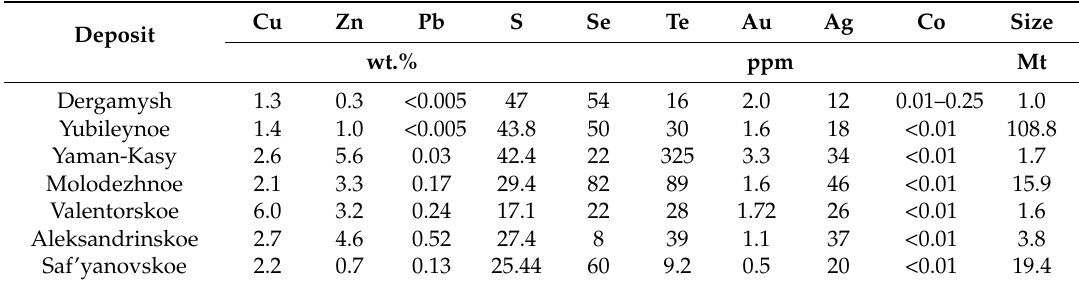
Table 1. Average composition and sizes of the Urals VHMS